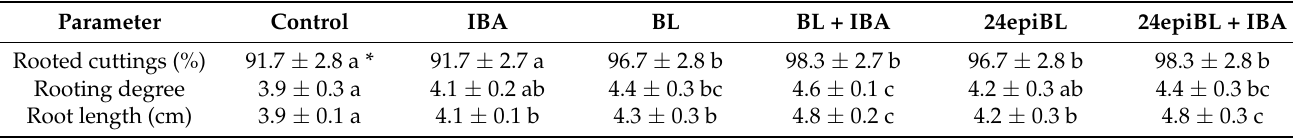
Table 3. Effect of brassinosteroids and auxin indole-3-butyric acid (IBA) on the rooting of cuttings in Berberis thunbergii ‘Maria’. Parameter